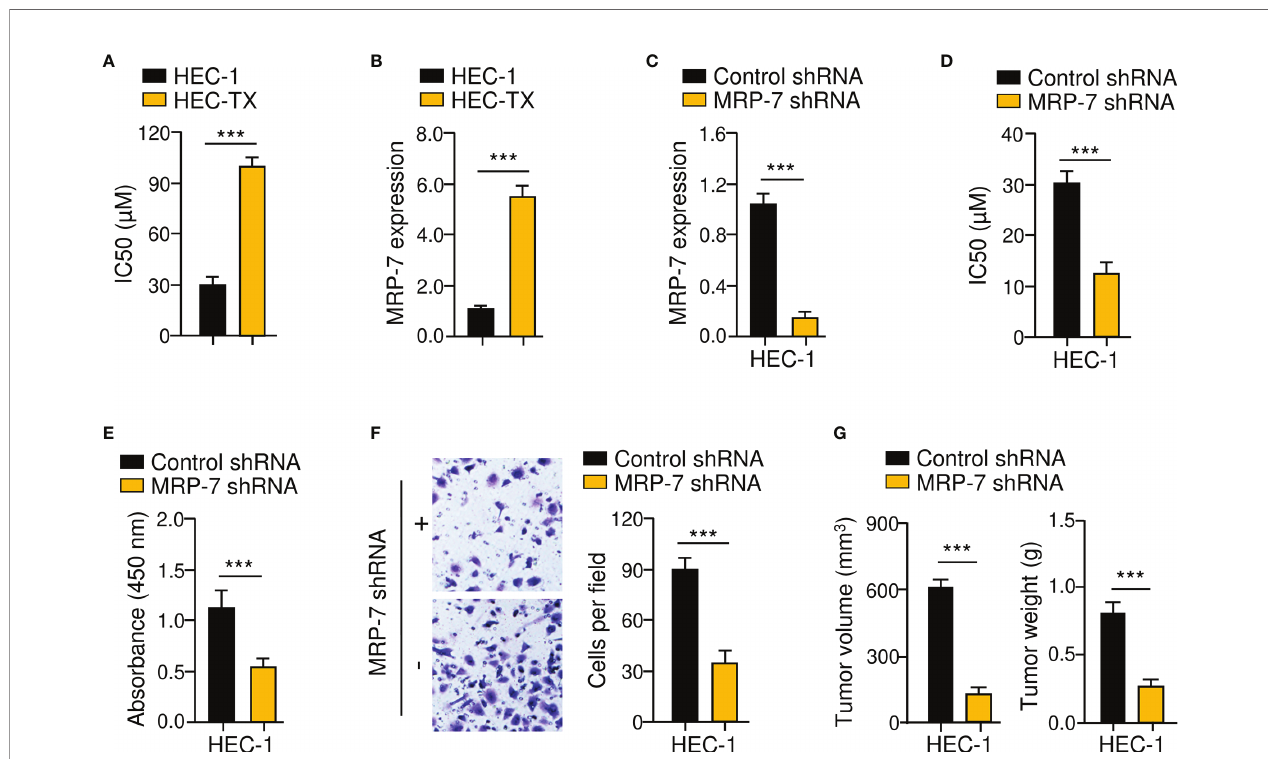
FIGURE 3 | MRP-7 Modulates Paclitaxel Resistance and EC Cell Invasion. (A) The cytotoxic effects of paclitaxel on paclitaxel-resistant HEC-1-TX cells and their parental cells. (B) The mRNA expression of MRP-7 in HEC-1-TX cells compared to their parental cells. (C) The qRT-PCR analysis of MRP-7 expression in HEC-1 MRP-7 shRNA cells and control cells. (D) MRP-7 knockdown increased the paclitaxel sensitivity of HEC-1 cells. (E, F) The proliferation (E) and invasion (F) of HEC-1 cells was attenuated after MRP-7 silencing. (G) HEC-1 cells transfected with MRP-7 shRNA (or control shRNA) were subcutaneously injected into nude mice. Tumor volume (left) and tumor weight (right) were displayed. *** P <